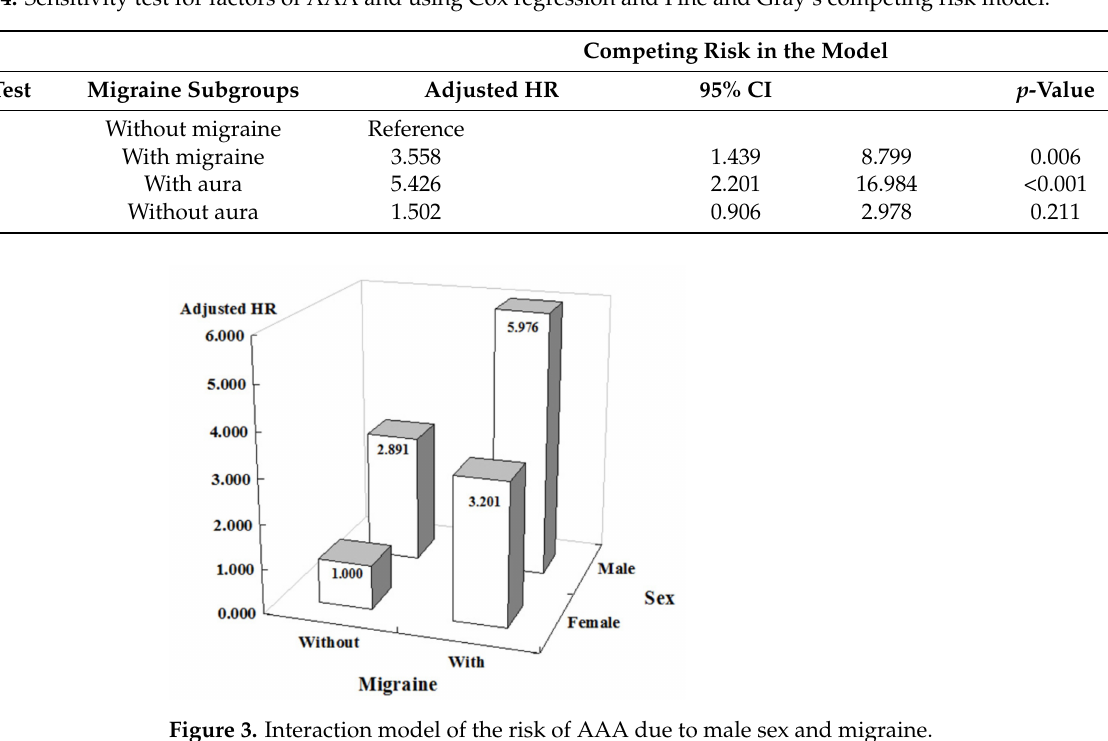
Table 4. Sensitivity test for factors of AAA and using Cox regression and Fine and Gray’s competing risk model.